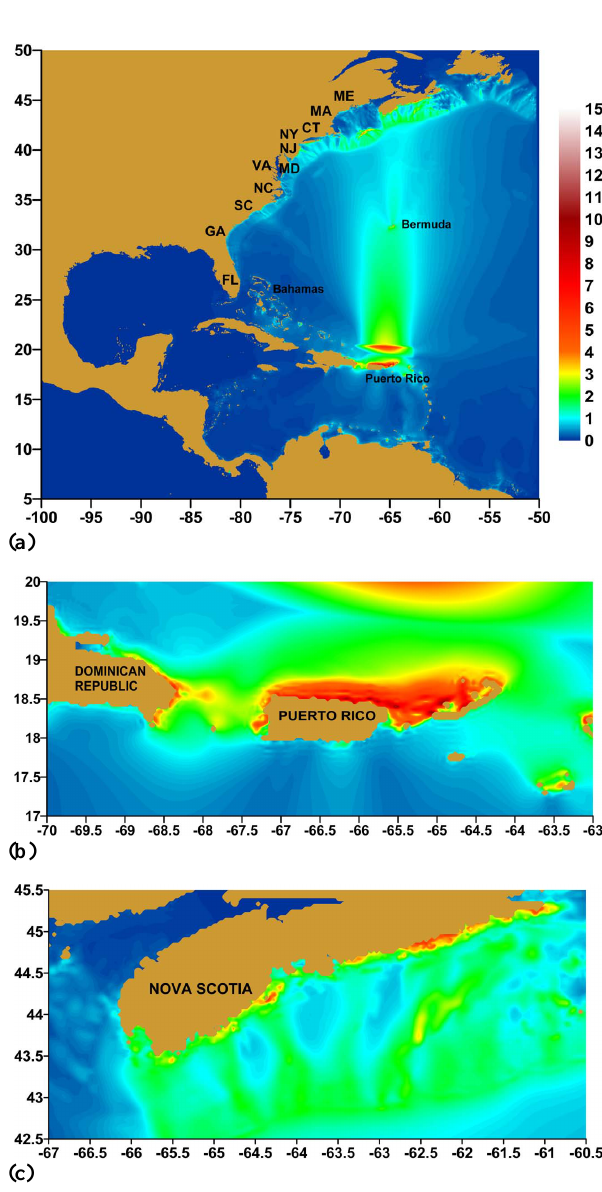
Fig. 3. FUNWAVE simulations over a 2 0 × 2 0 grid, using ETOPO-2 bathymetry, for the 9.1 co-seismic tsunami source of Fig. 2a (axes are in degrees of N Lat. and W Long.). (a–c) Maximum surface elevations (color scale in meter) at anytime during computations. (b) Zoom near and around Puerto Rico; (c) zoom near Nova Scotia. areas. Southwest of this region, large elevations shown in Fig. 3a correspond to the shallows of Georges Bank,